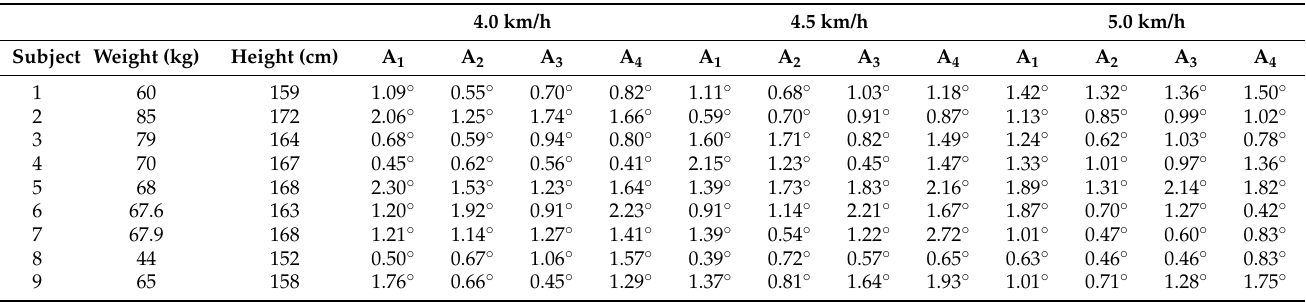
Table A2. MAD of each one of the four differences at different speeds in all